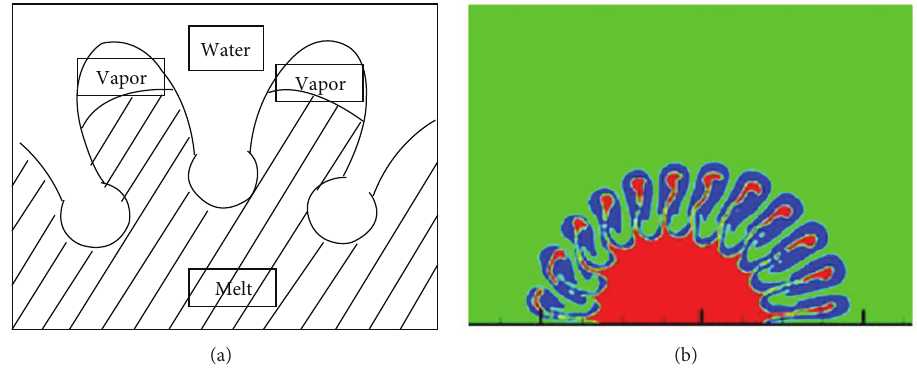
Figure 11: Description of Kim’s model [7] (a) and Zhou’s simulation result [9] (b).